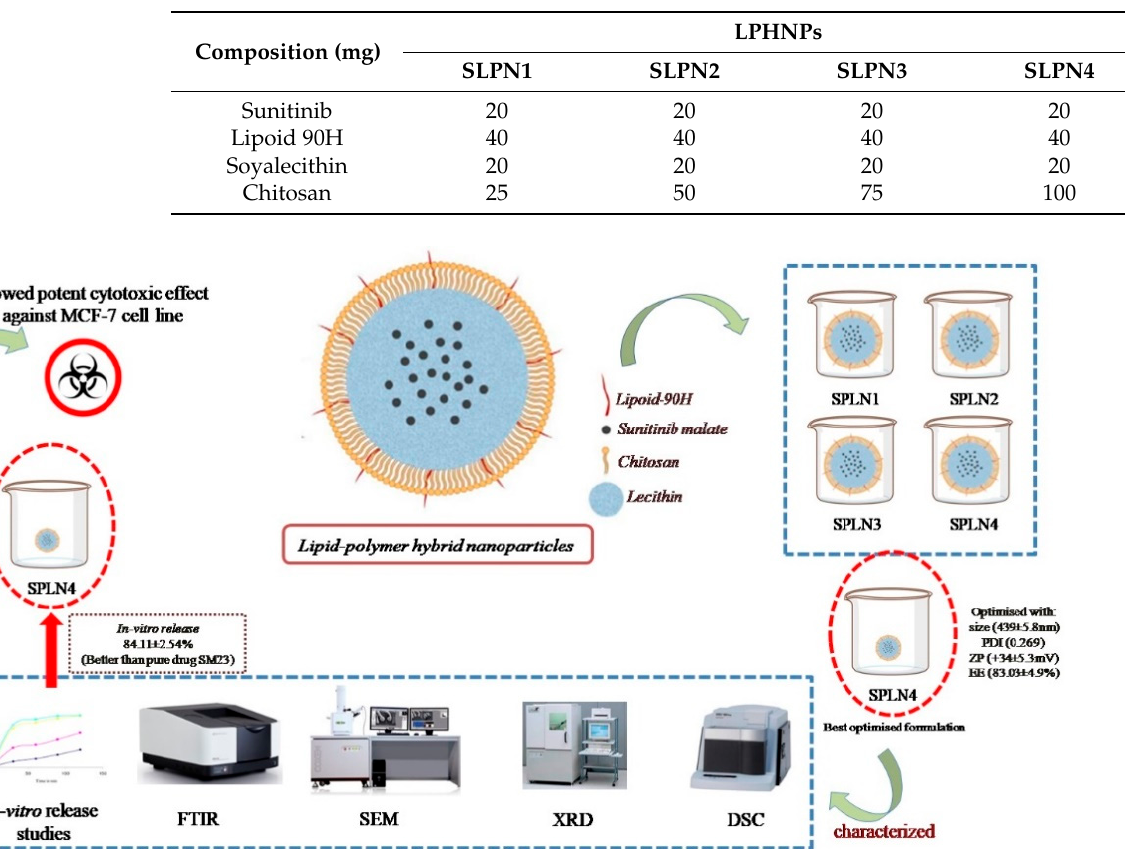
Table 1. Composition of SM-loaded LPHNPs.